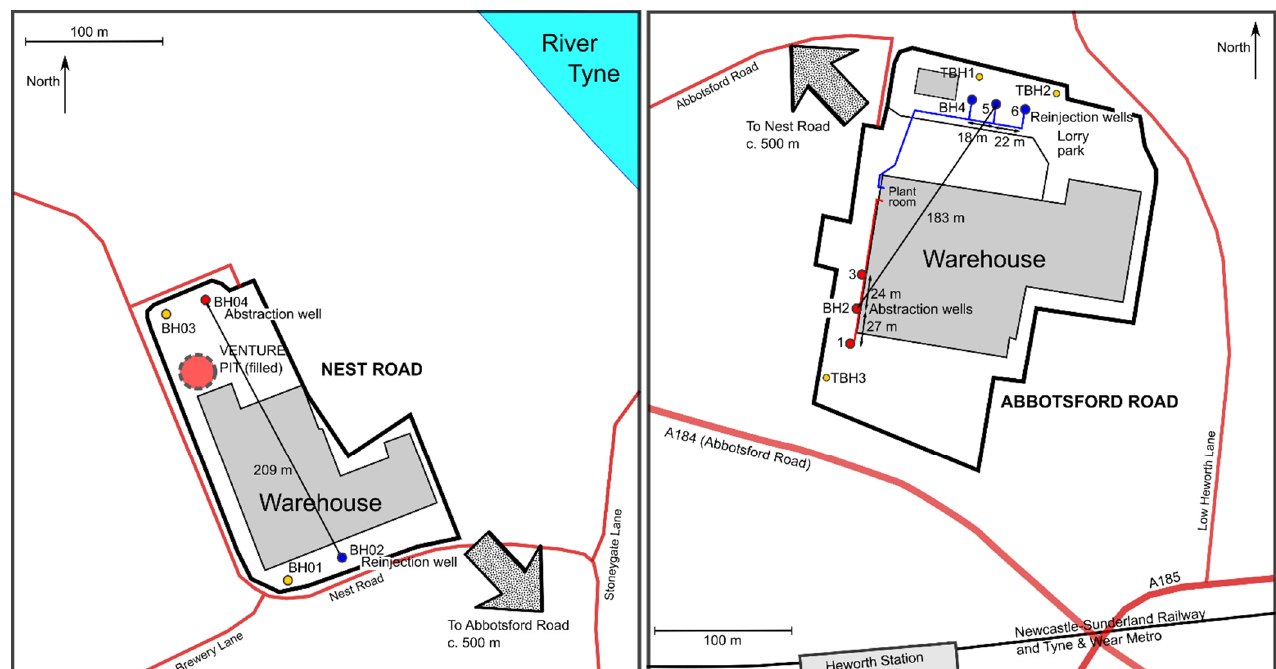
Figure 2. Schematic maps of the ( left ) Nest Road and ( right ) Abbotsford Road sites.